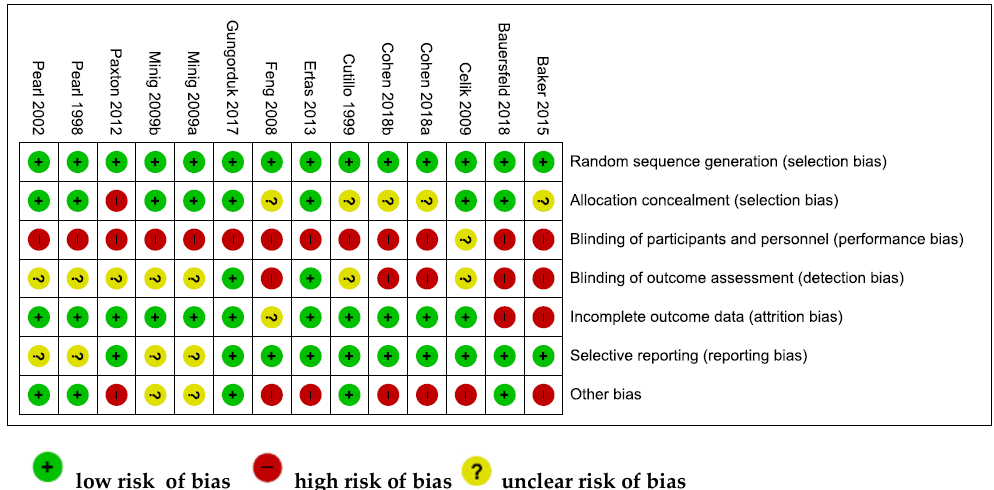
Figure 3. Risk of bias summary: review authors’ judgments about each risk of bias item for each included study.